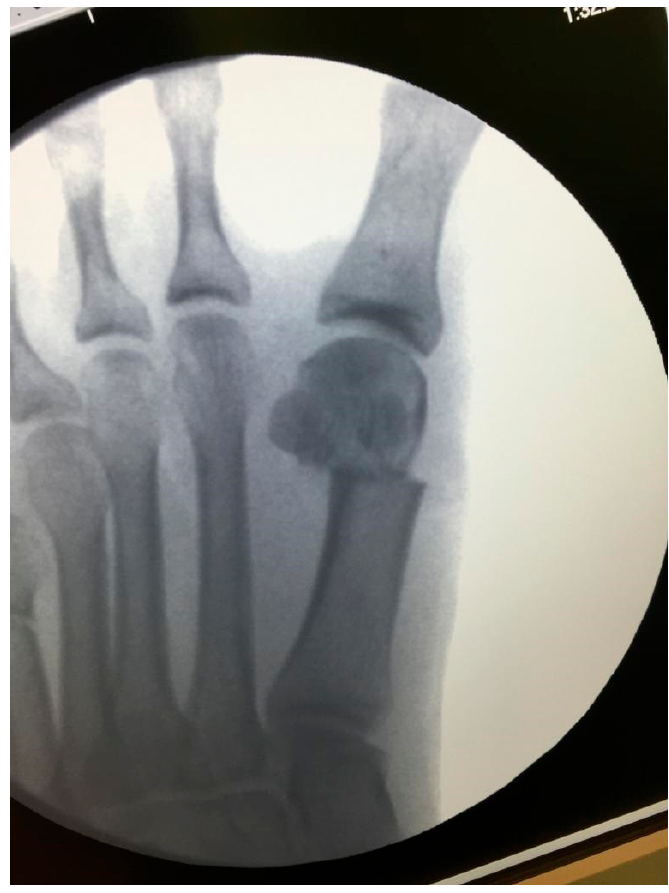
Figure 1. Fluoroscopic view of metatarsal metaphyseal osteotomy with lateral head displacement.